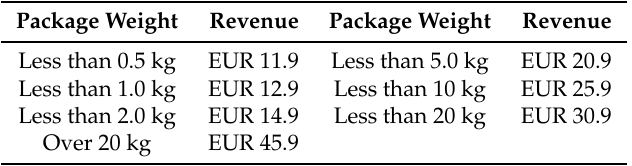
Table 2. Shipping rate of Deutsche Post DHL